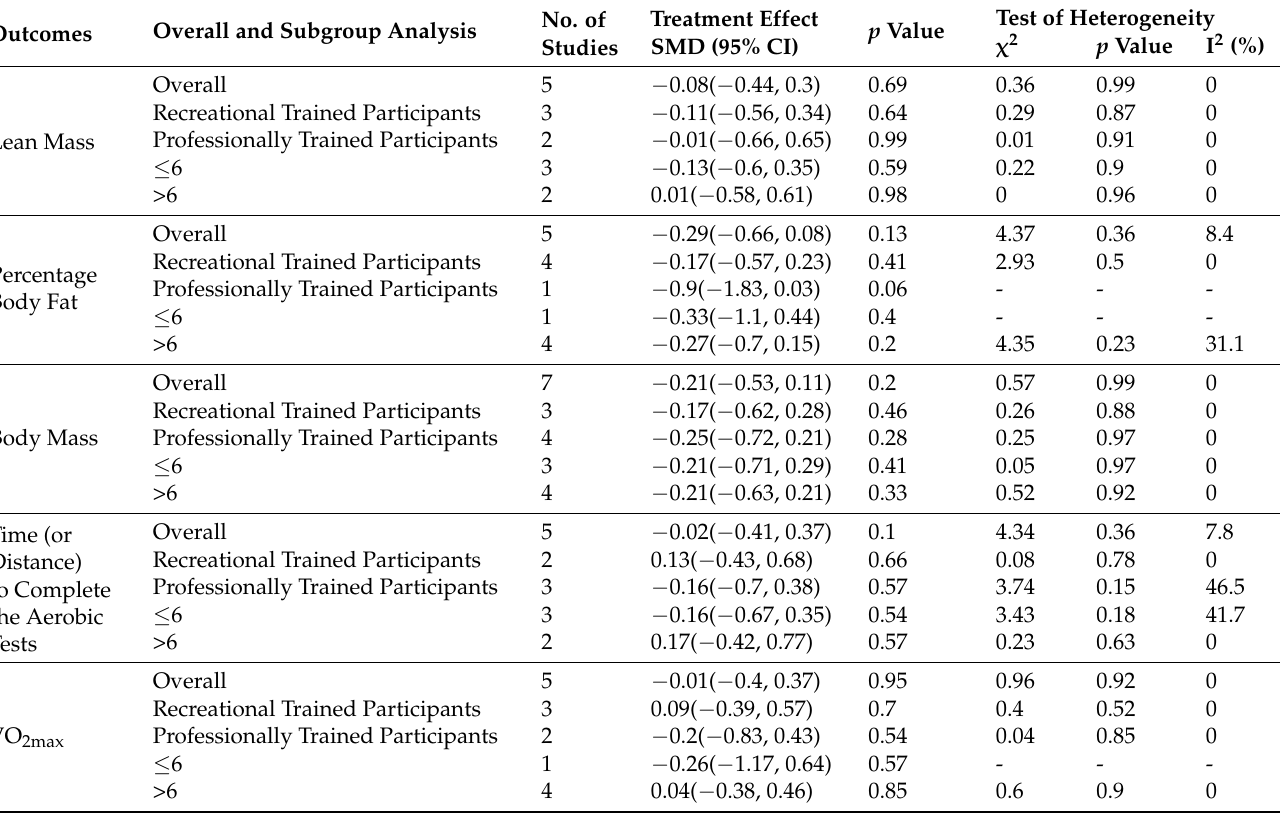
Table 3. Overall and subgroup analysis results regarding the